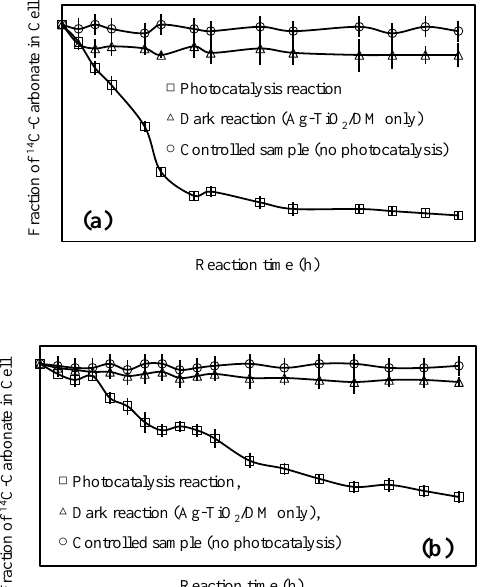
Figure 4. Time courses of cell densities of Microcystis aeruginosa cultures during incubaction period.